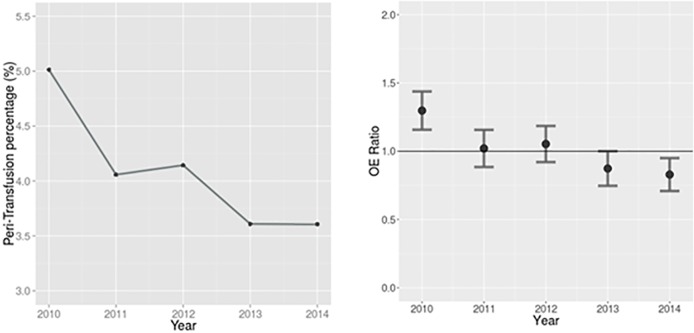
Annual trend of peri-procedural transfusion.(a) shows unadjusted percentage of the transfusion, and there was 28% decrease in the transfusion rate from 2010 to 2014 (5% to 3.6%, p = 0.001). (b) shows adjusted transfusion trend using the developed risk model. A horizontal line is at OE ratio = 1. OE ratio in 2010 and 2014 were 1.3 (95% CI: 1.2–1.4) and 0.83 (0.71–0.95), respectively.